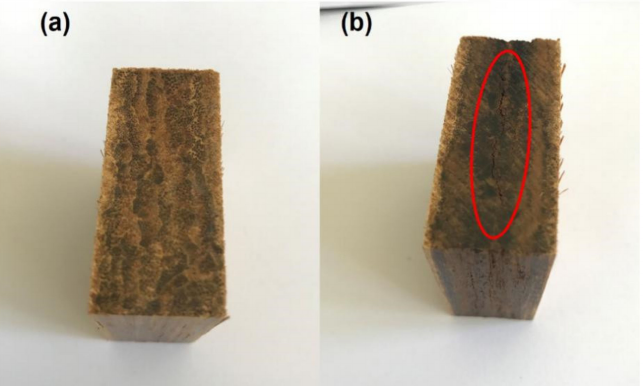
Figure 1. ( a ): Sample produced at a hot press temperature of 180 ◦ C without crack; ( b ): obvious crack in sample produced at a hot press temperature of 200 ◦ C.